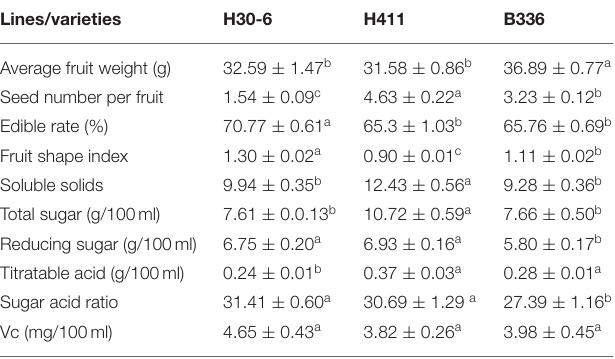
TABLE 1 | Fruit qualities during three consecutive years (2019 to 2021). Lines/varieties